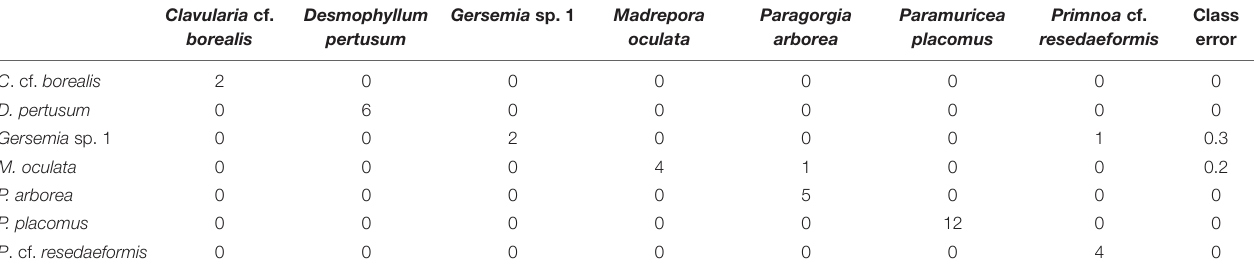
TABLE 3 | Confusion matrix of the Random Forest analysis.